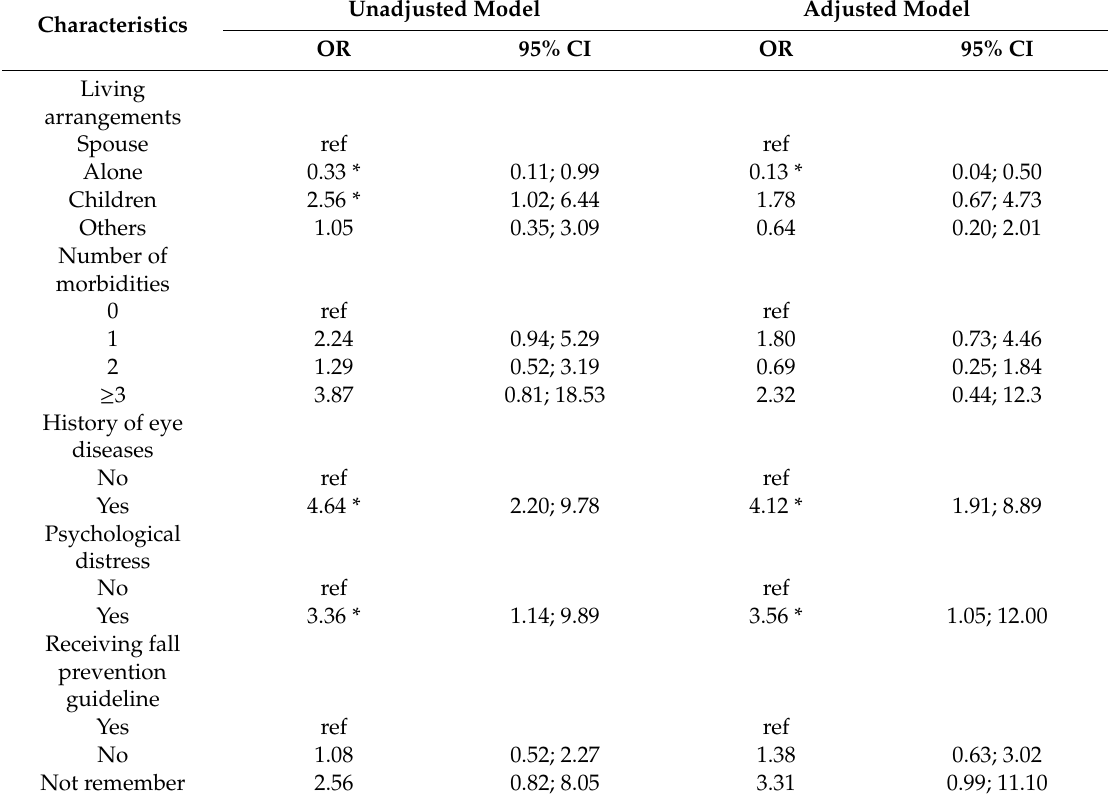
Table 3. Associated factors with FOF.